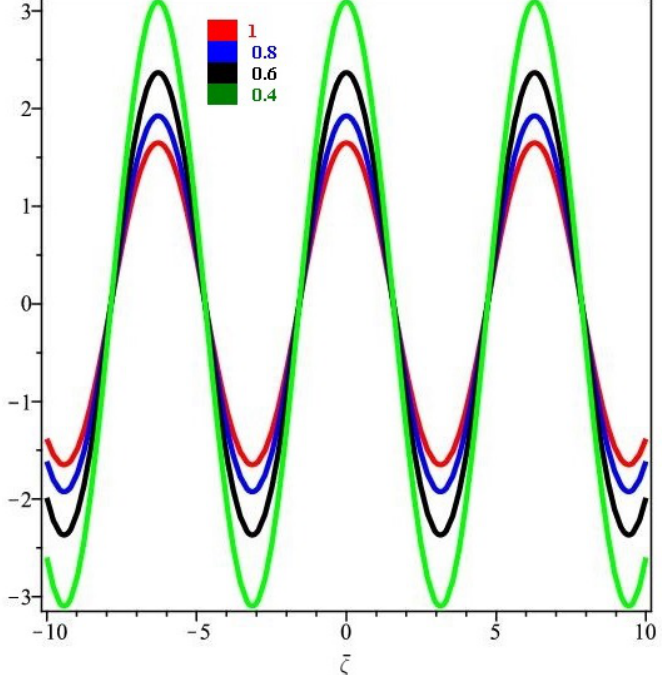
Figure 9. The different fractional-order of β with respect to ¯ ζ for Example